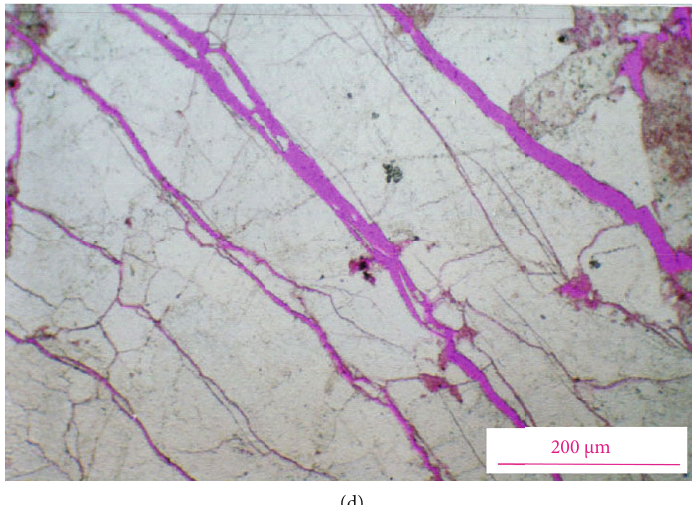
Figure 3: Thin sections of photomicrographs showing microscopic features of Dibei tight sandstone reservoirs in Ahe Formation. (a) Well a, brachy pores: the pores are intersected by fractures and are nearly in rounded shape. (b) Well Yn2, J Yn5, J 1 fl at and long-axis shape. (c) Well Yn4, J a: the secondary dissolved micropores are developed in clustering and banding form. (d) Well Yn5, 1 J a: the micro fi ssures are nearly parallel with bigger openness, without impurity between fi 1